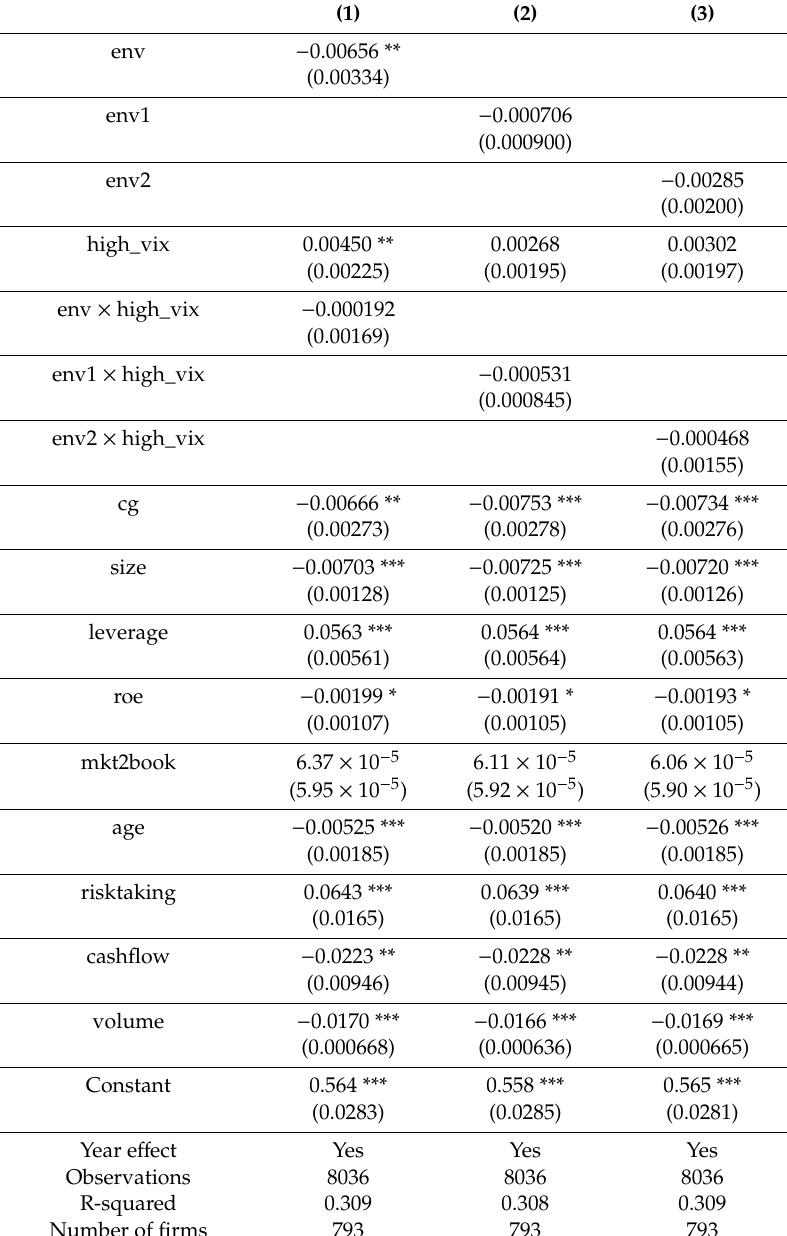
Table 4. Di ff erence-in-di ff